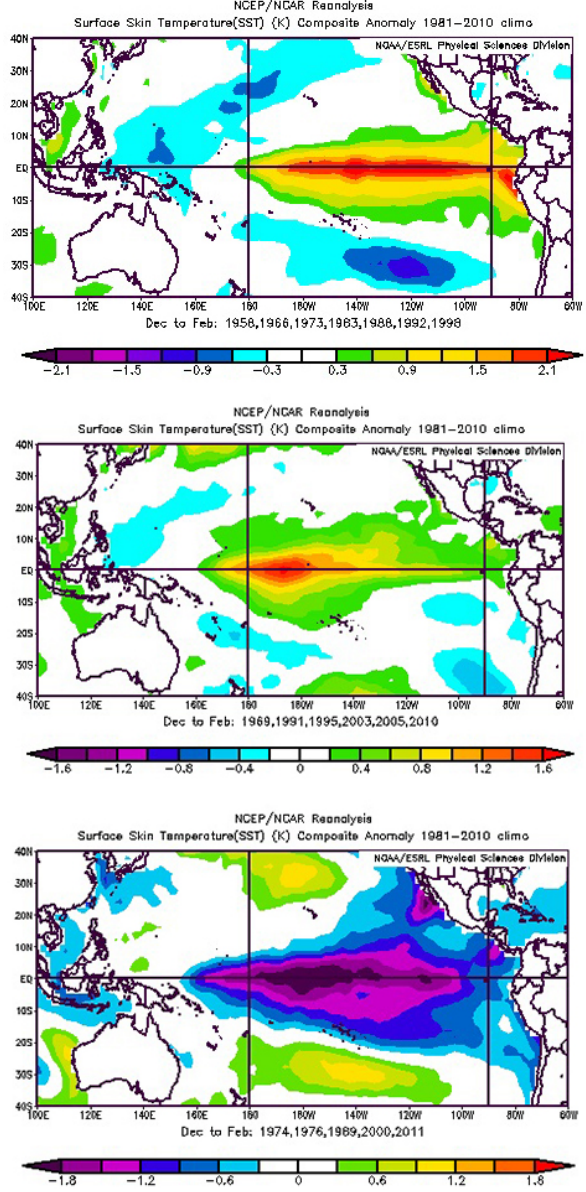
Figure 2. Composite sea surface temperature anomalies (SSTA) in the TPO region in developing phases of two types of El Niño and La Niña during December–January. (a) to (c) indicate SSTA during CT/WP El Niño and La Niña years,